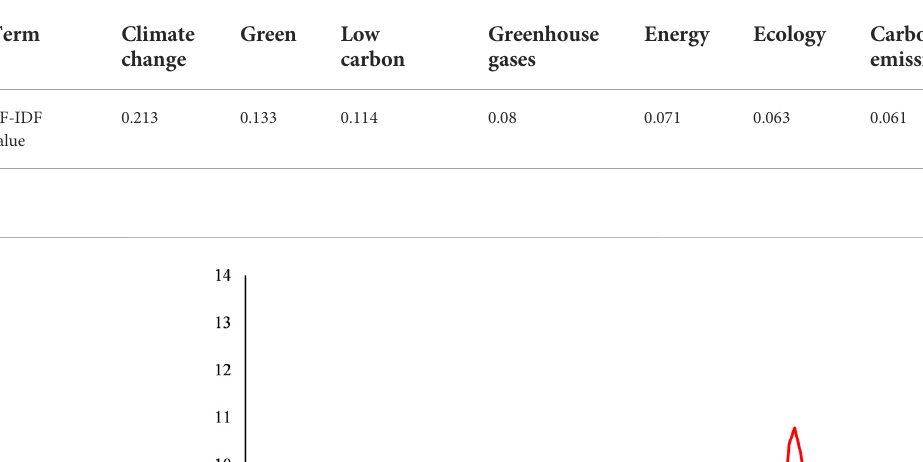
TABLE 2 Term with TF-IDF value exceeding